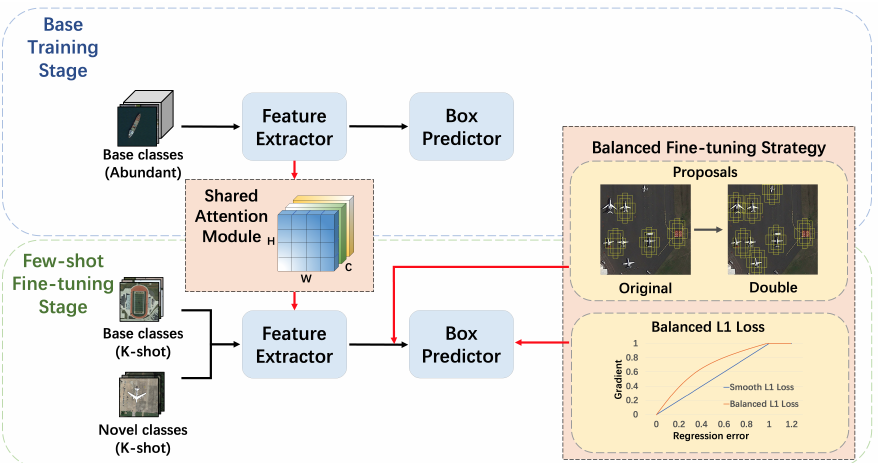
Figure 3. Framework of the proposed method for few-shot object detection on remote sensing images. Our method consists of two main components: a shared attention module (SAM) between the backbones and a balanced fine-tuning strategy (BFS). The SAM extracts the multi-dimensional attention map from the base training stage and shares it to the few-shot fine-tuning stage as prior knowledge to improve the localization of novel class objects. With the help of it, the BFS improves the performance of few-shot object classification on remote sensing images by solving the imbalance between the number of samples from base classes and novel classes.